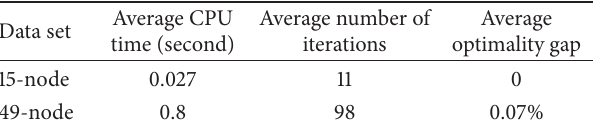
Table 2: Algorithm performance.